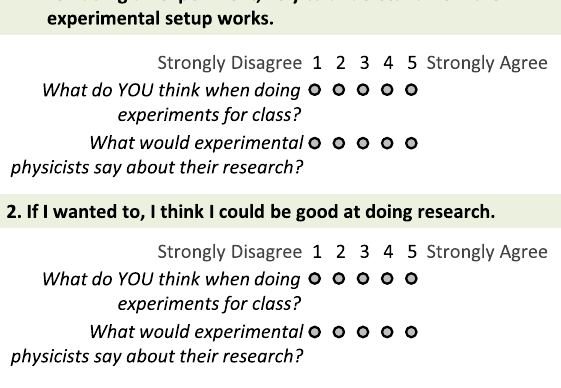
FIG. 1. Two epistemological beliefs statements as they are presented to students in the pre and post E-CLASS online survey.